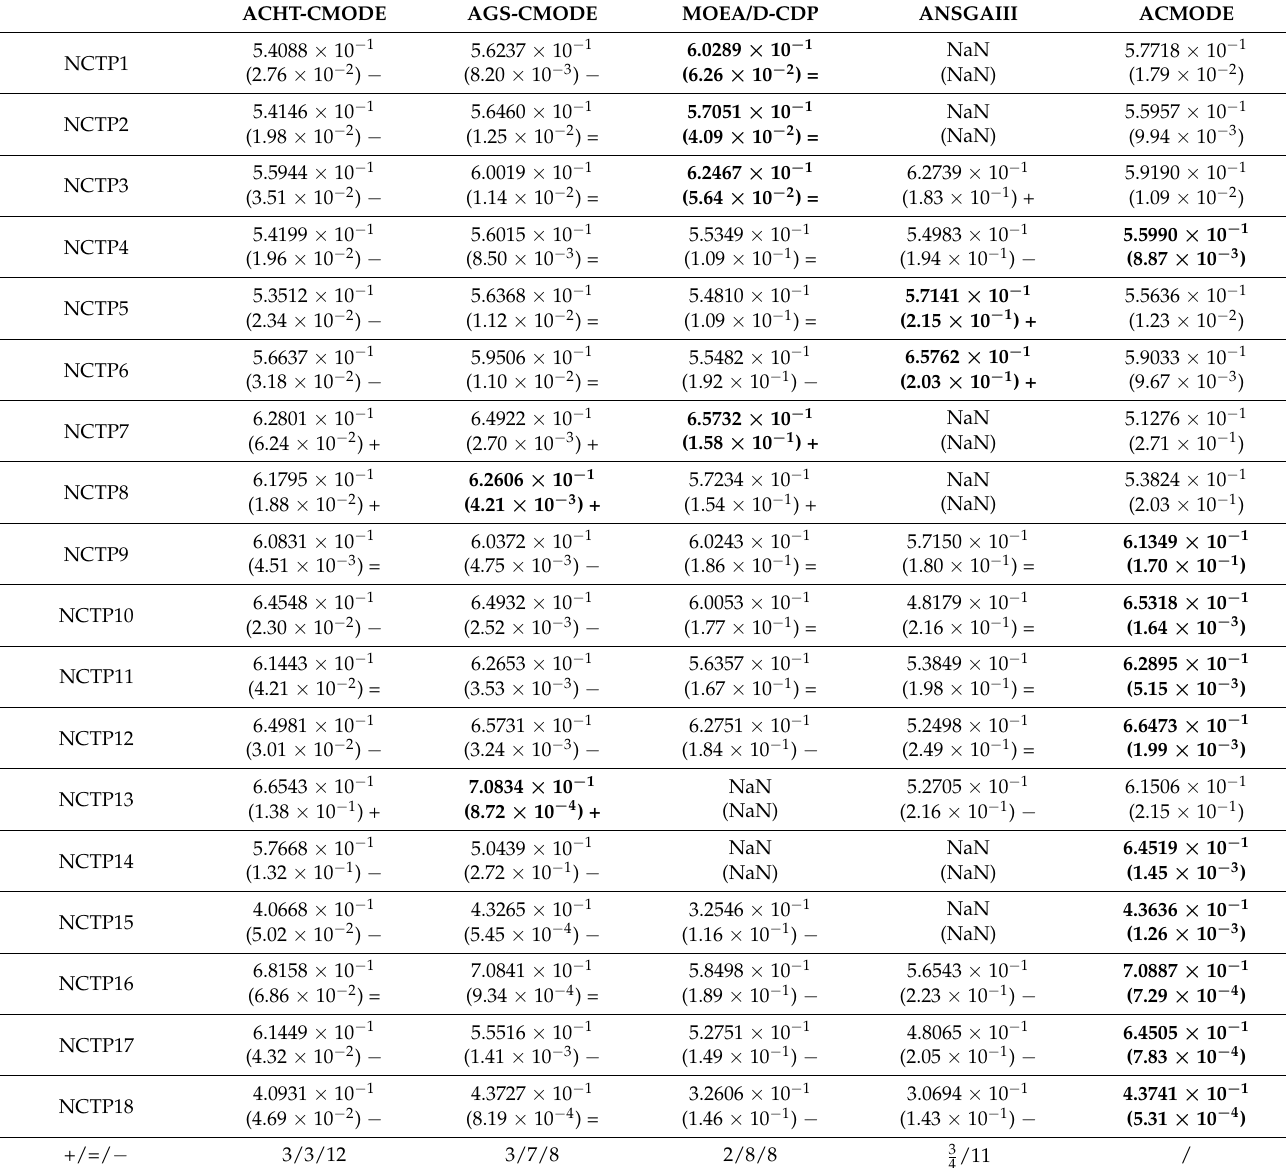
Table 7. HV results of all comparison algorithms on NCTP test